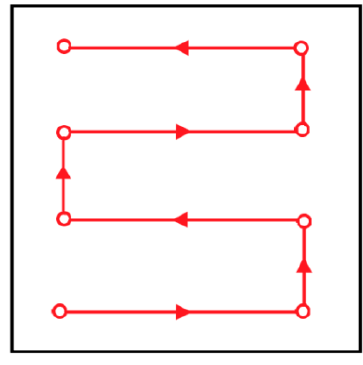
( c ) Figure 6. Fractal dimension. ( a ) Original image, ( b ) 4 × 4 fractal dimension, ( c ) 9 × 9 fractal dimension.